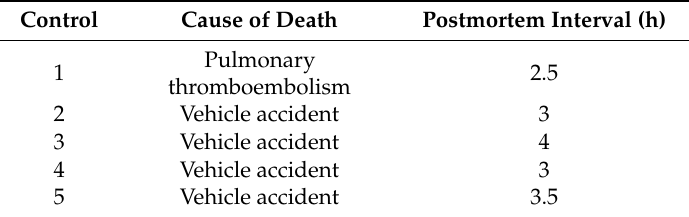
Table 1. Summary of clinical data from control subjects and postmortem